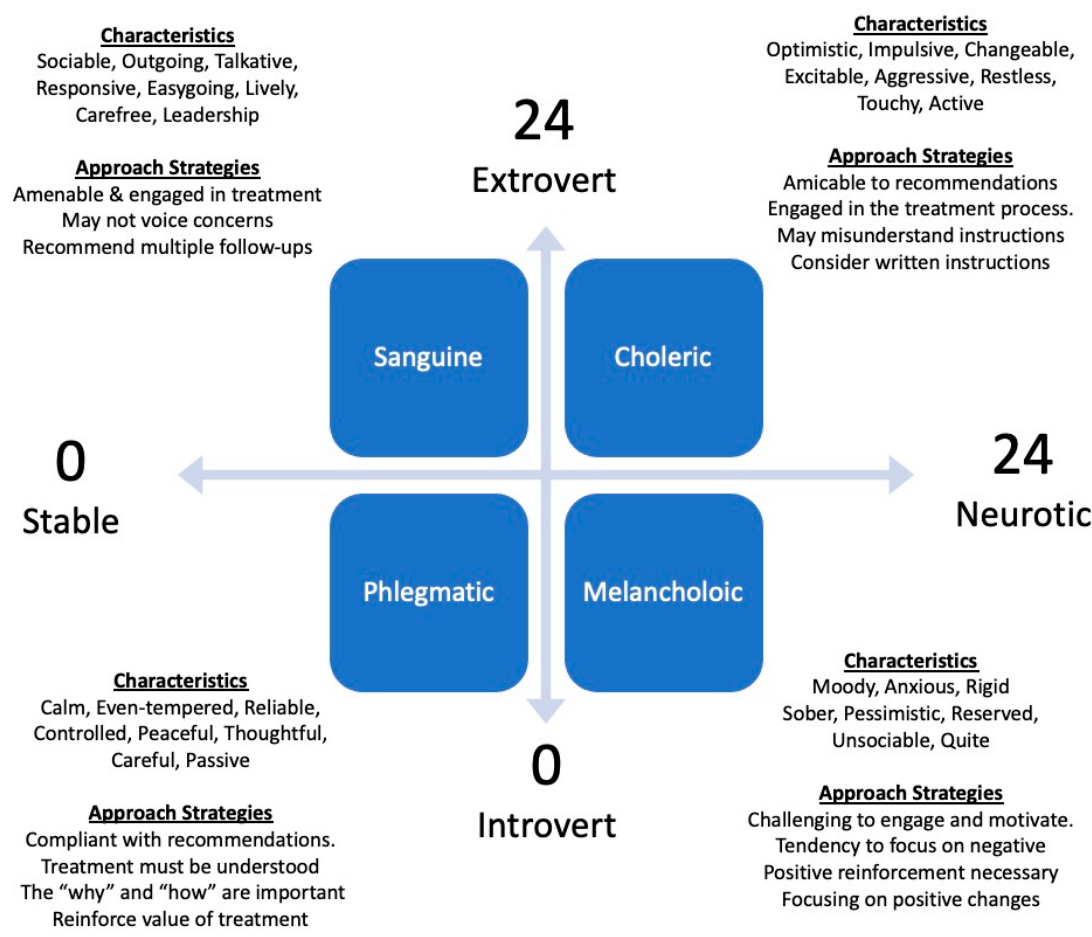
Figure 1. Eysenck’s Personality Inventory, subtype classifications, characteristics and approach strategies. Adapted from [27].